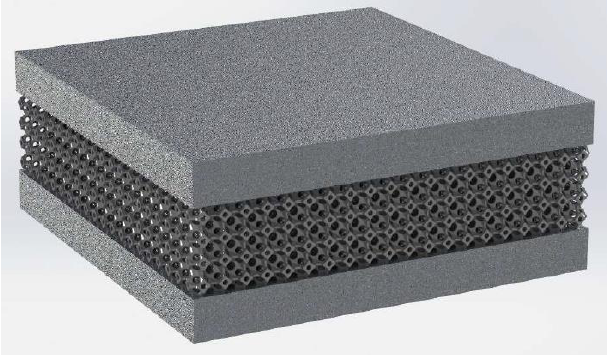
Figure 2. Porous matrix made by modified BCC cells between the two plates.